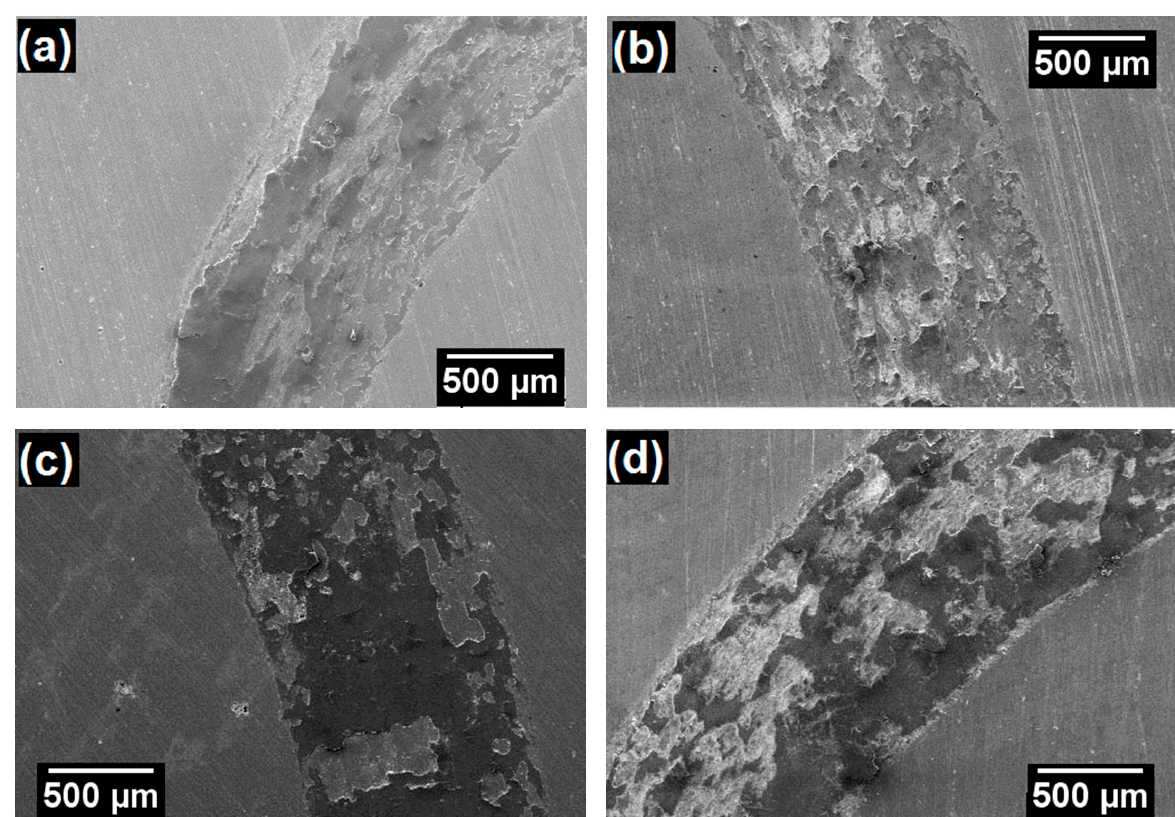
Figure 10. SEM and EDS of the 316L bulk ball-on-disk testing track. ( a ) 50×. ( b ) 1000×, where (1) is a region with abrasion- type wear marks and (2) is a region with adhesive-type wear. ( c – f ) EDS mappings.